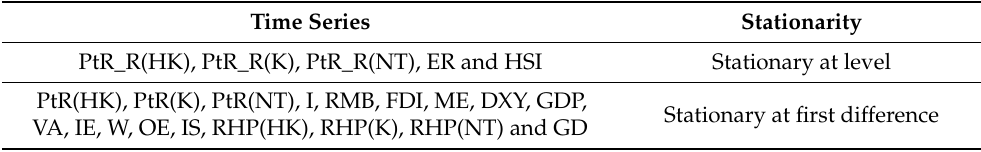
Table 2. Summary of the results of the ADF tests. Time Series